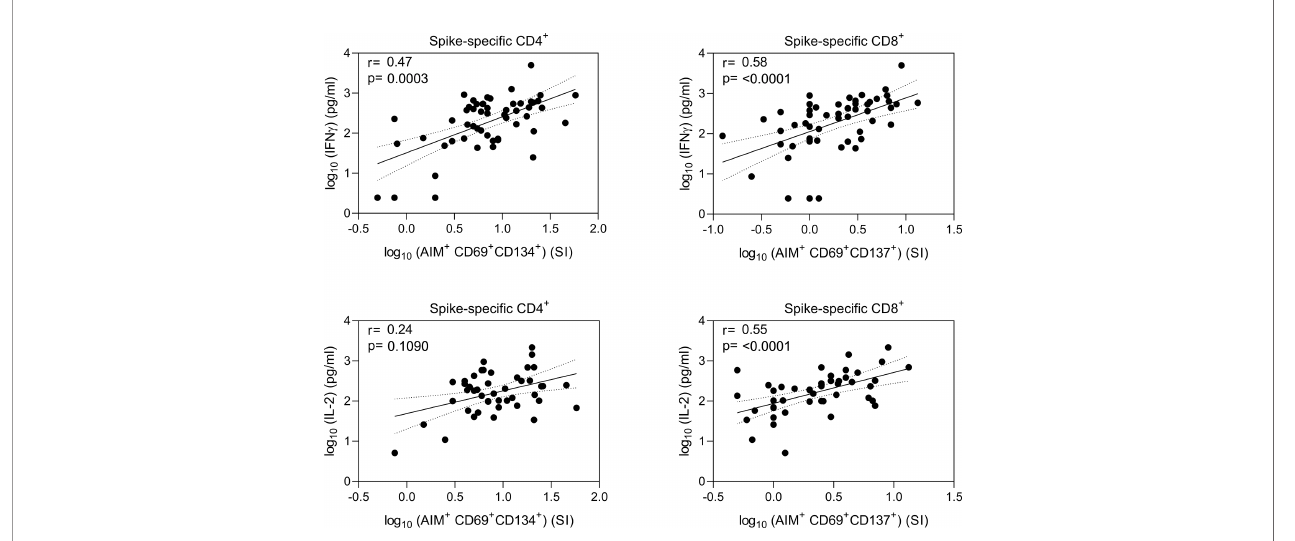
FIGURE 5 | Correlation of spike-speci fi c T cell responses. Nonparametric Spearman correlation analysis of secreted IFN- g and IL-2 concentrations with AIM + CD4 + and CD8 + T cells in wild type (wt) SARS-CoV-2 spike protein-speci fi c peptide pool stimulated PBMCs. Results are shown from 15 BNT162b2 vaccinated health care workers at three timepoints after two doses of BNT162b2 vaccine (n=37 fro IFNg and 32 for IL-2), 10 COVID-19 patients, and 8 for IFNG and 3 for IL-2 healthy non- vaccinated controls. Dotted lines indicate 95%